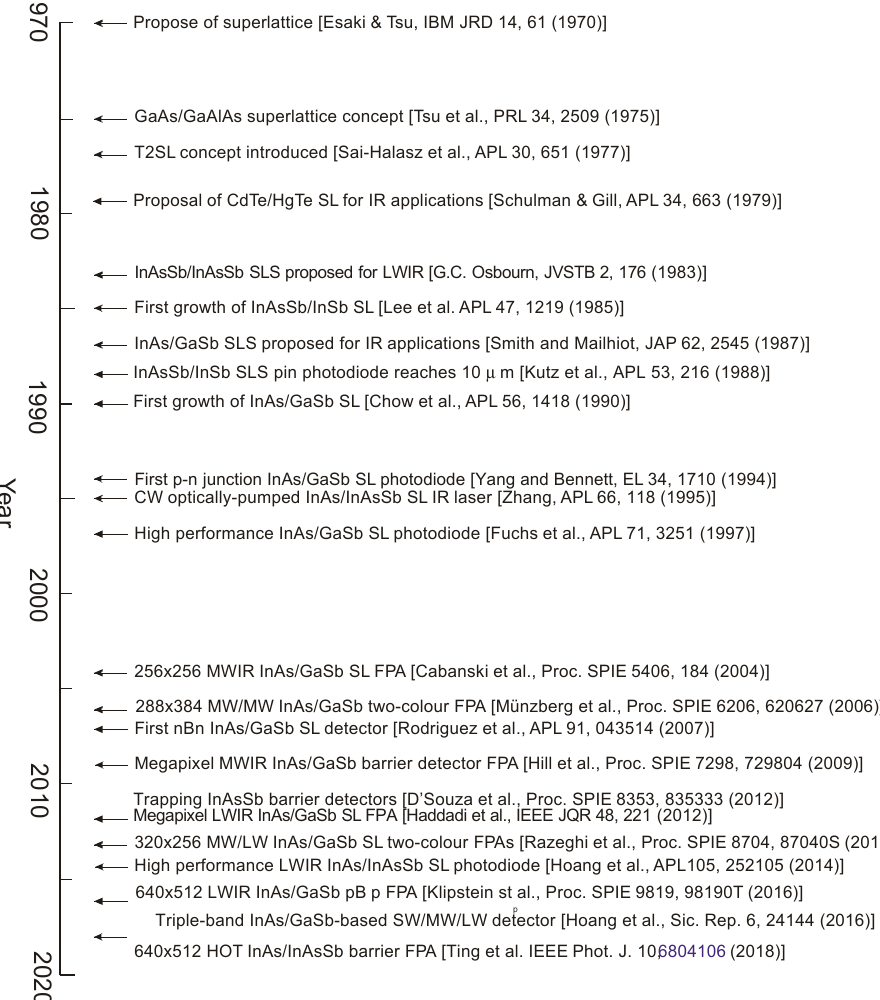
Figure 52. Roadmap development of T2SL IR photodetectors including InAs / InAsSb SL photodiodes and barrier detectors.